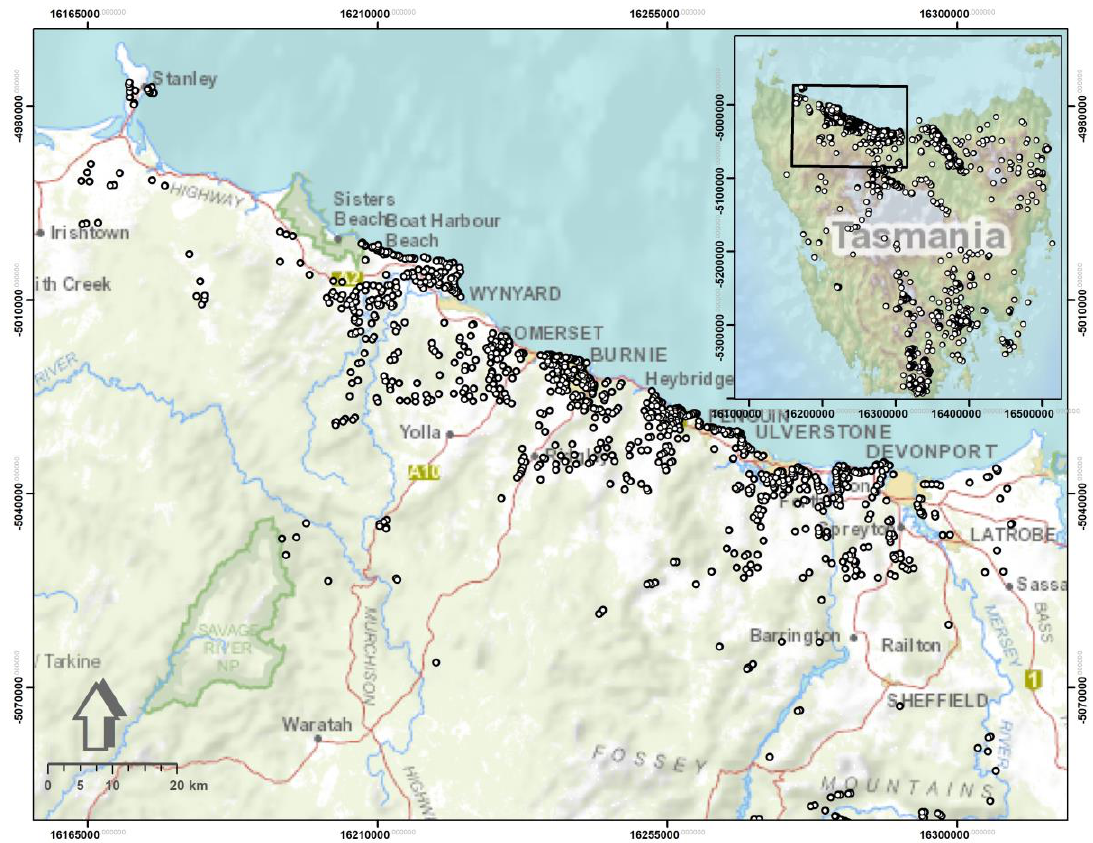
Figure 1. A location map of the study area. Dots represent the location of occurred various landslide events.